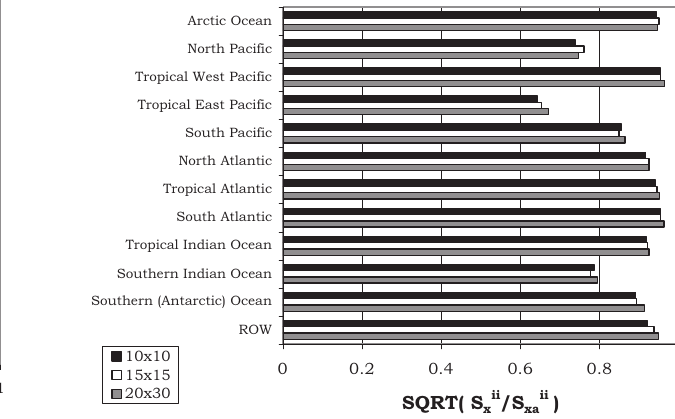
Examination of the uncertainty reduction (the difference between unity and the ratio of the a posteriori to a priori un- certainties) across all the regions indicates that the TES data provide the largest error reduction on the fluxes when aver- aged on 10 ◦ × 10 ◦ scales. At 10 ◦ × 10 ◦ , 6 regions gave an error ratio less than 0.50, compared to 5 regions with the 20 ◦ × 30 ◦ data. These regions are South American Tropical Rain Forest, Southern Africa Grasslands, South and Central Europe, Northern Africa Grasslands, East Asia Mainland, and South American Wooded